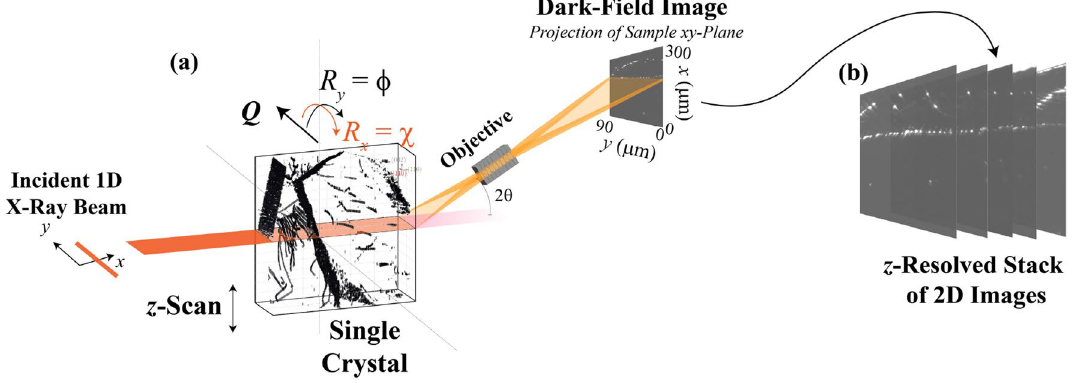
Figure 1. Schematic showing the DFXM experiment and how it captures each image in our 3D reconstruction, as plotted in the laboratory coordinate system. This study focuses on dislocation structures observed by diffraction contrast from the (002) Bragg reflection, with a corresponding diffraction angle of 2 θ = 20.77 ◦ . To obtain 3D information, DFXM images were collected for 2D layers using a line-focused beam ( 200 × 0.6 µ m (FWHM) in the y and z directions), scanning the sample in the vertical direction, z , to resolve variation along the height of the crystal (as shown in Fig. 1a). The observation plane for each image shown by the orange plane that slices through the cube showing the dislocations we observed in our single crystal. The direction of the scattering vector Q can be varied by the two tilts, φ and χ . The length of the scattering vector can be varied by a combined 2 θ − φ scan. The figure is made using the MATLAB code in the link https:// github. com/ leora dm/ Dislo catio n3DAn alysis.